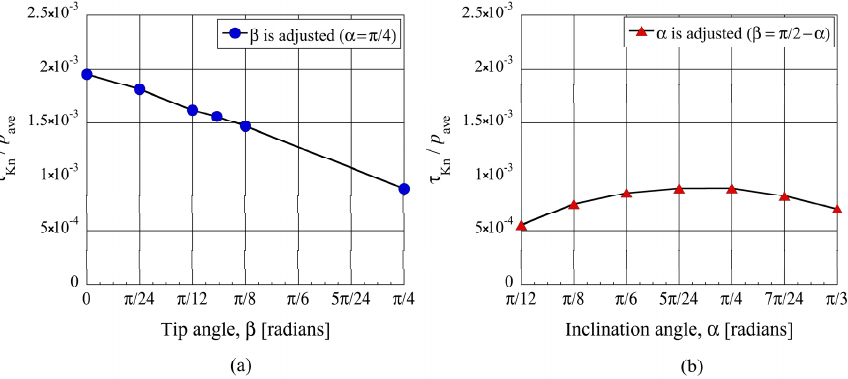
Figure 7. Net tangential Knudsen stresses, i.e., propulsive forces per unit area, at ( a ) different tip angles 𝛽 for the modified ratchet and ( b ) different inclination angles 𝛼 for the ratchet, for Kn = 1 .